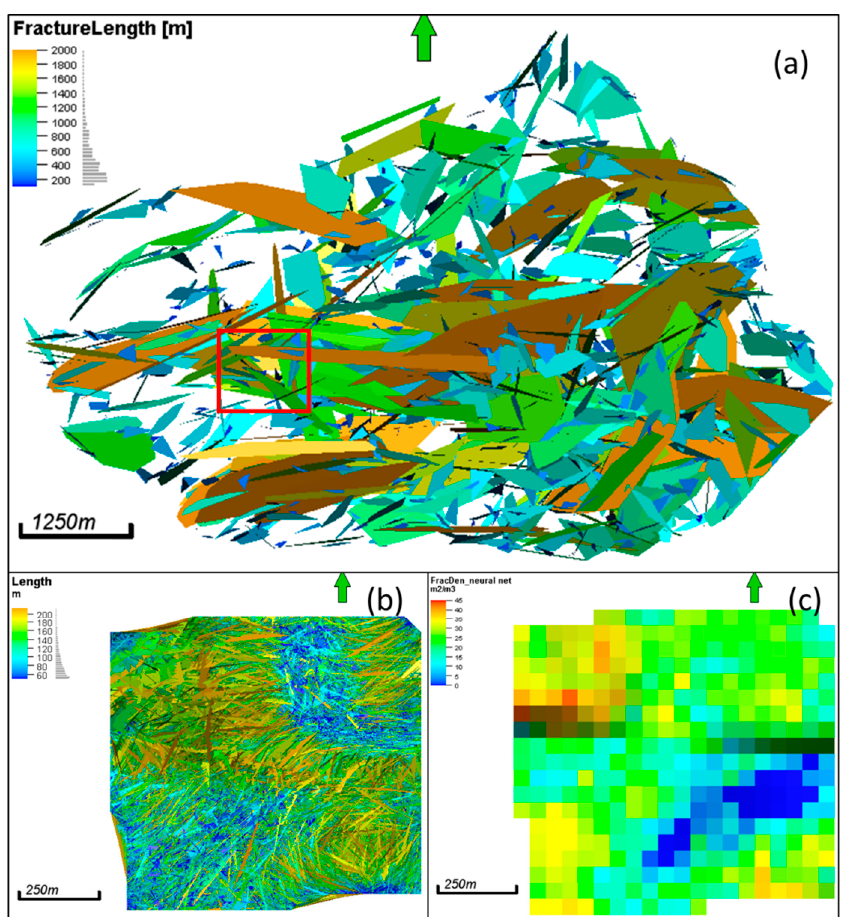
Figure 14. Discrete fracture model of large-scale fractures and small-scale fractures. The model of LSFs ( a ); the red square indicates the area where SSFs were generated. The model of SSFs ( b ); the fracture density of the SSFs are in the same position as Figure 14b ( c ).